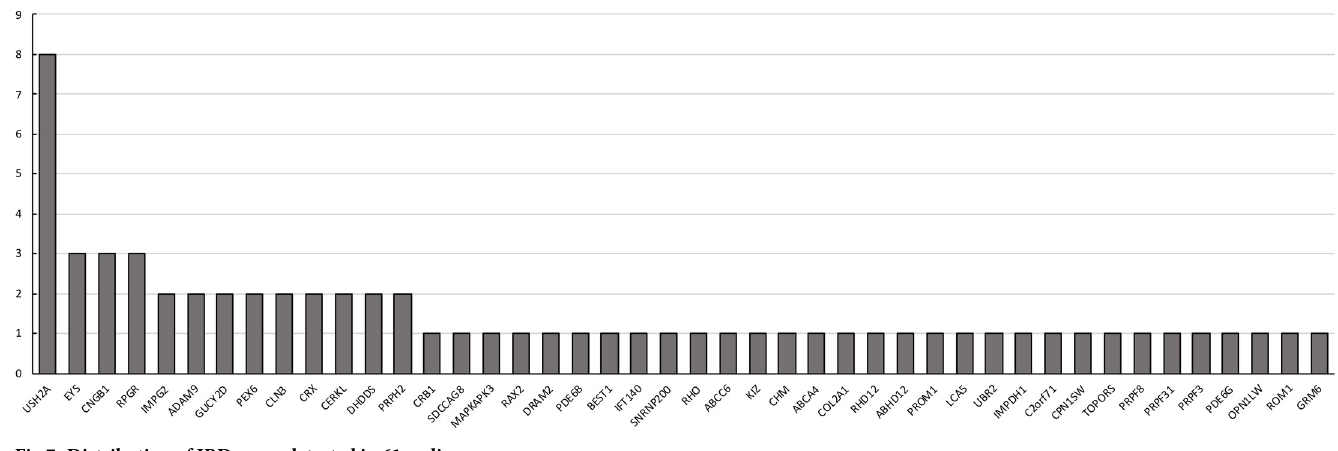
Fig 7. Distribution of IRD genes detected in 61